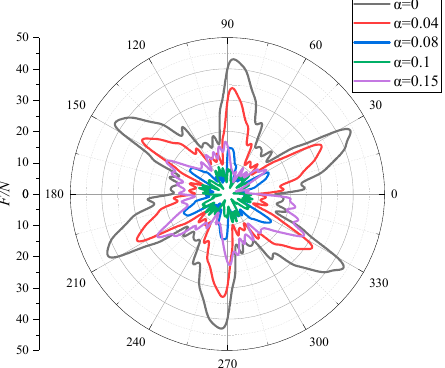
Figure 9. The radial force distributions of the impeller under di ff erent inlet gas fractions.